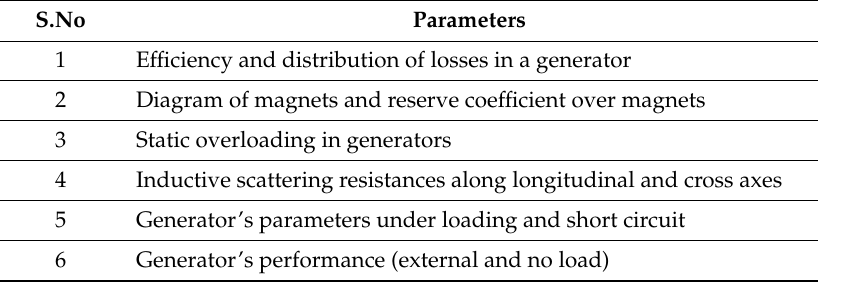
Table 3. Parameters need to be considered for mathematical